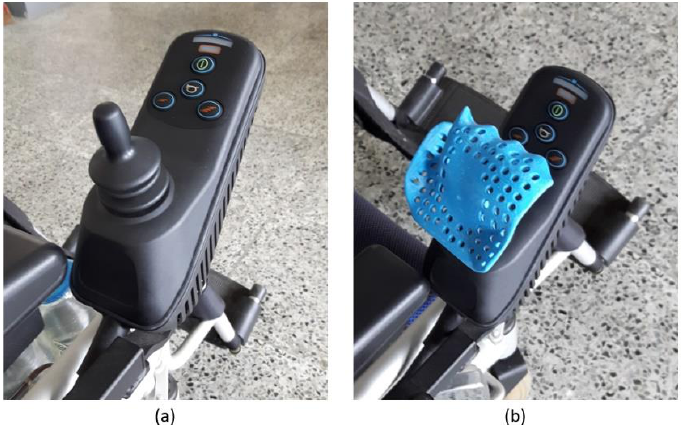
Figure 5. ( a ) Conventional steering controller (CSC); ( b ) Mounted 3D-printed steering controller (3DSC) (blue part).